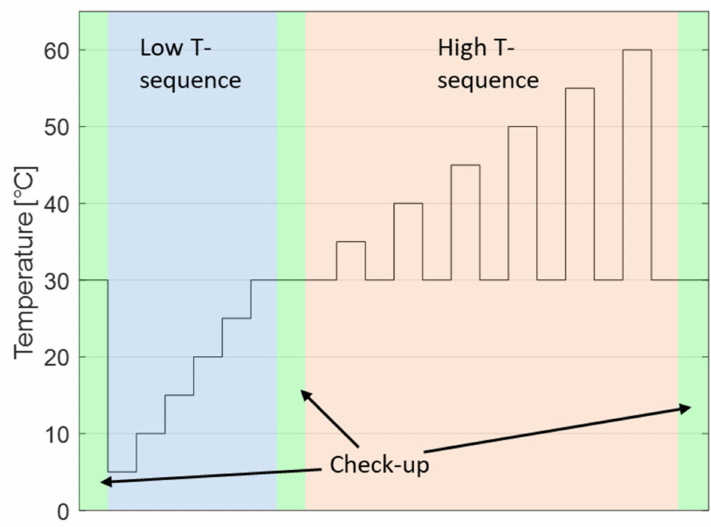
Figure 1. Test strategy described in temperature over test